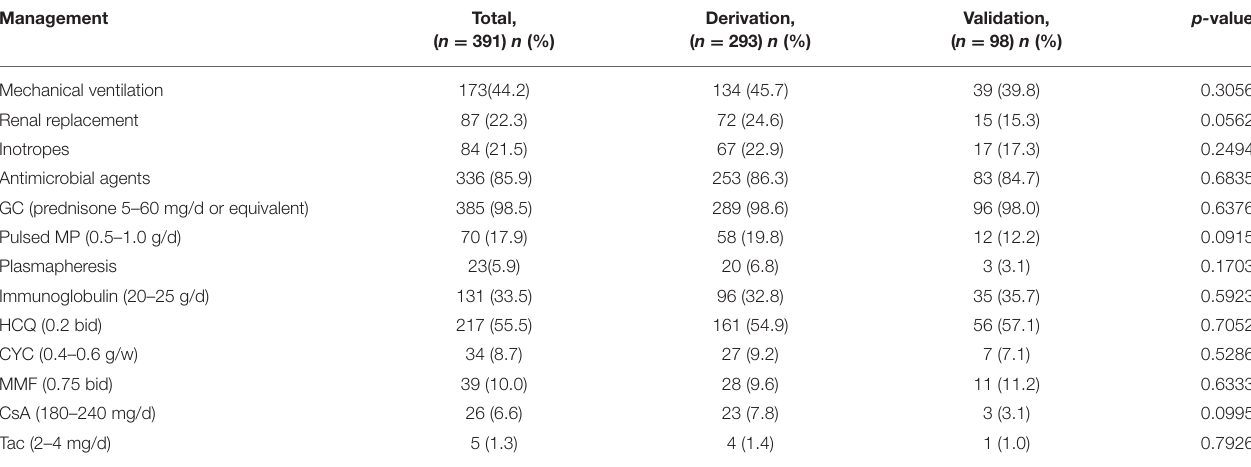
TABLE 4 | Management during ICU of the 391 patients.